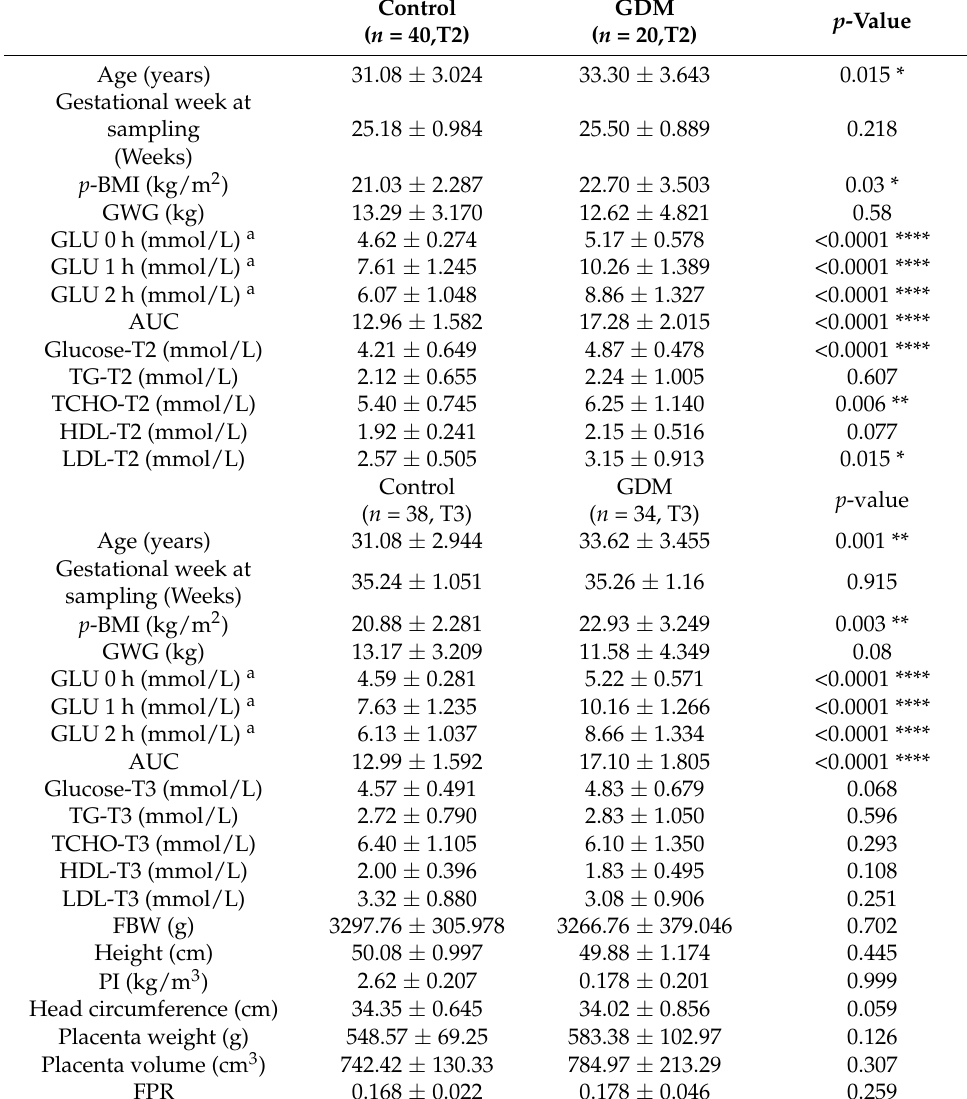
Table 1. Characteristics of the study population in the second and third